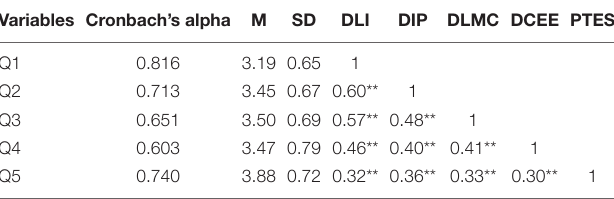
TABLE 1 | Descriptive statistics and correlation among variables.